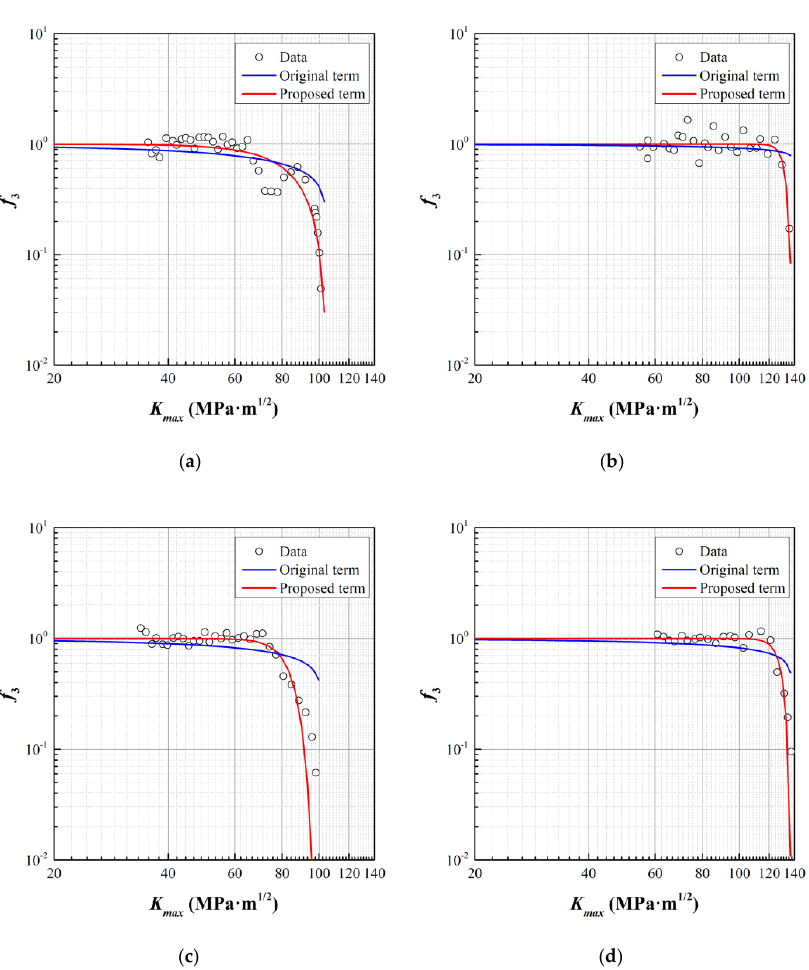
Figure 5. Experimental data and fitting results for the original and proposed f 3 . ( a ) T = 600 °C, t h = 10 s; ( b ) T = 700°C, t h = 10 s; ( c ) T = 700°C, R = 0.1; ( d ) T = 700°C, R = 0.5. The fitting results for original term and proposed term are listed in Table 5. Table 5. Fitting parameters for the original and proposed f 3 .